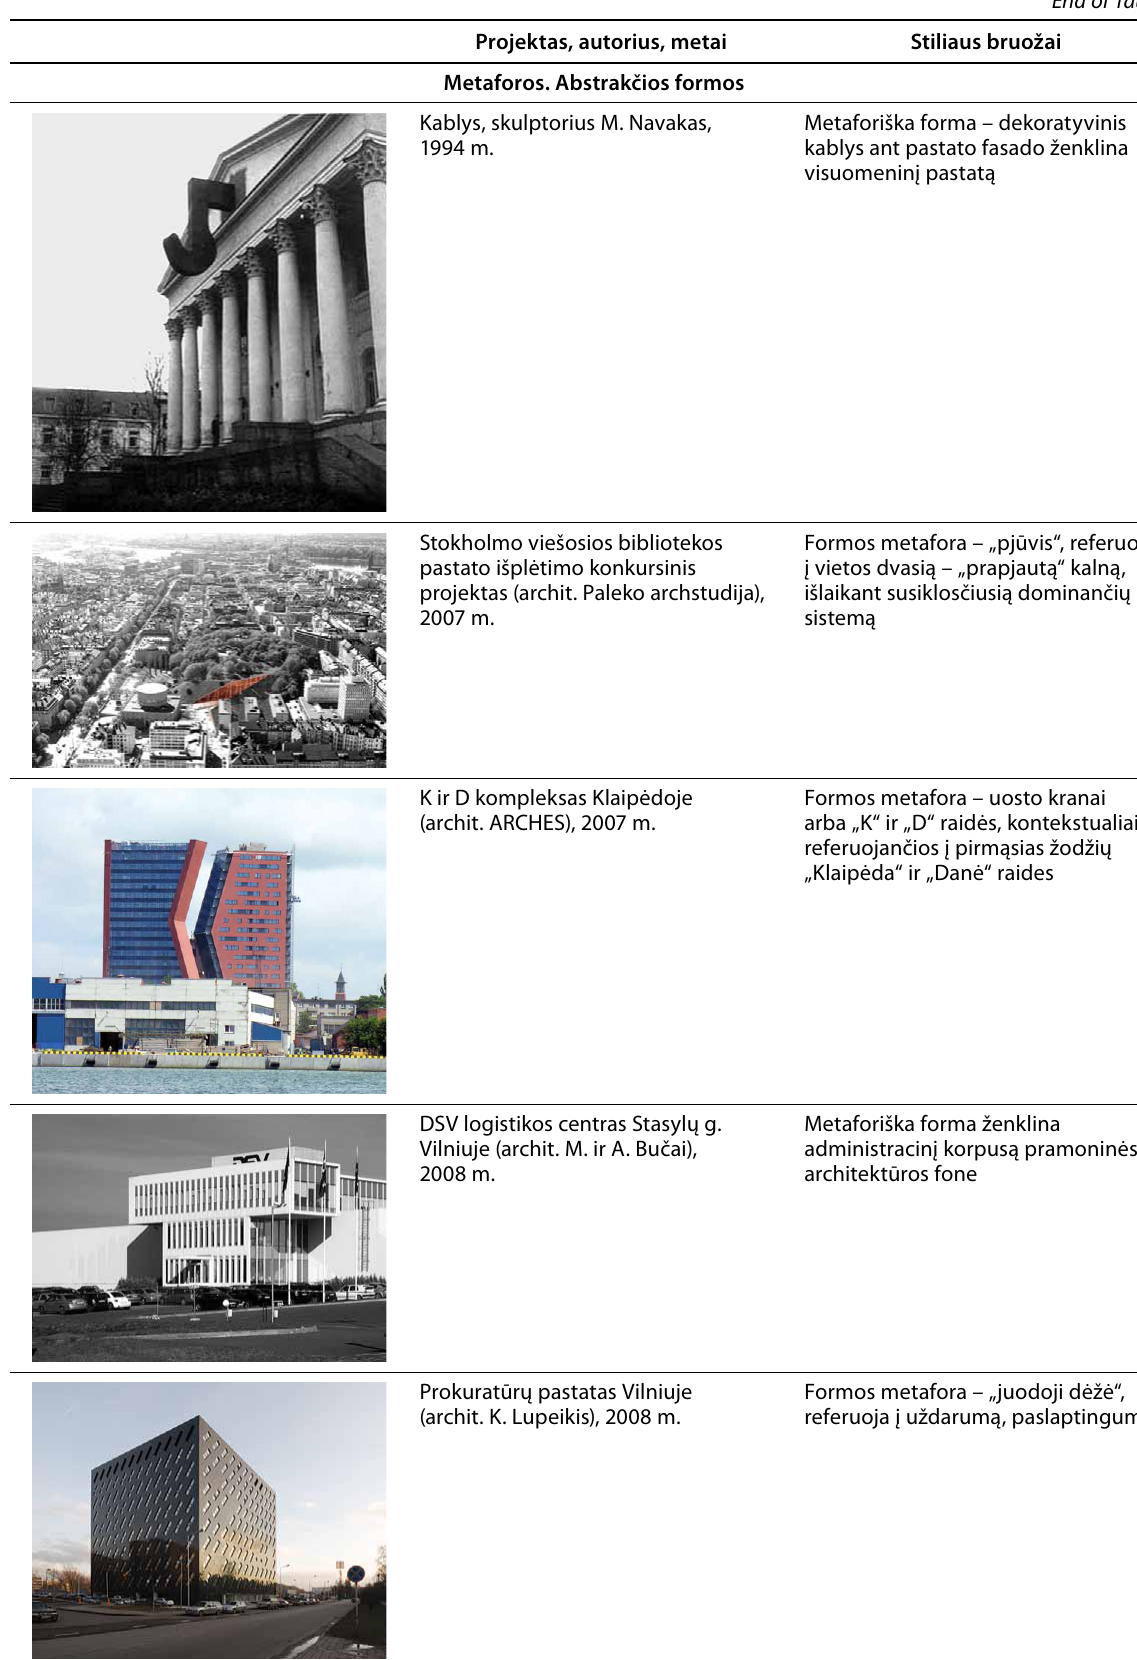
DSV logistikos centras Stasylų g. Vilniuje (archit. M. ir a. Bučai), 2008